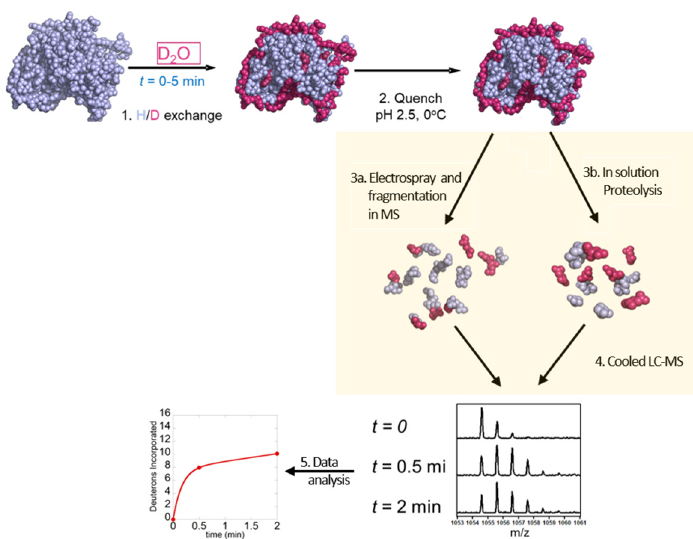
Figure 3. Schematic overview of top-down and bottom-up HDX-MS workflow: 1—exchange of hydrogen to deuterium for different time points (0–5 min), 2—quenching at low pH, 3a—proteolysis, 3b—electrospray and fragmentation in MS 4—separation of peptides by LC–MS and 5—data analysis.